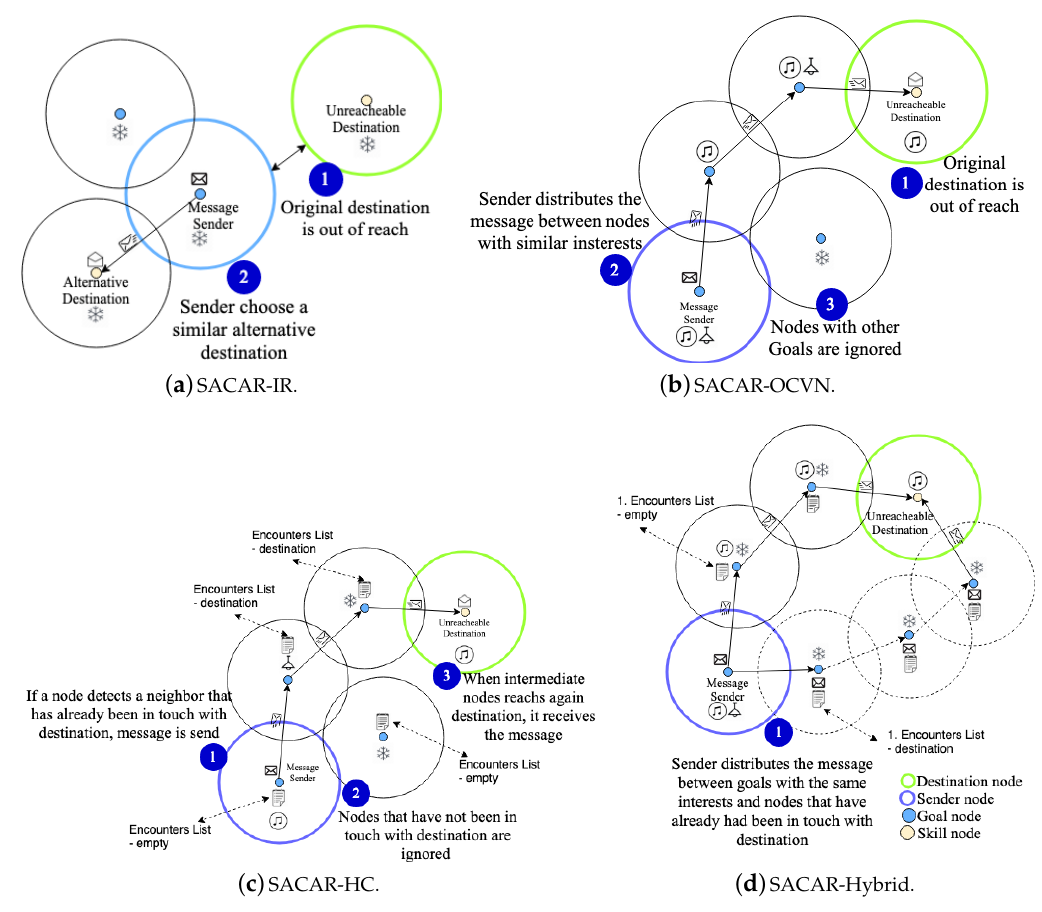
Figure 3. Behavior of the defined Situational and Adaptive Context-Aware Routing (SACAR) algorithms. IR, In Range; HC, Historical Contacts.